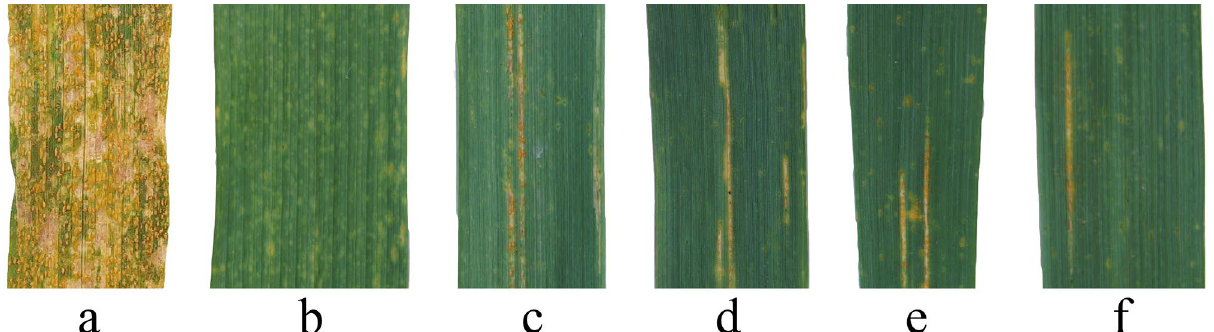
Figure 3. Stripe rust resistance of synthetic wheat at the adult stage. ( a ): SY95-71; ( b ): Ma; ( c ): Syn-SAU-116; ( d ): Syn-SAU-117; ( e ): Syn-SAU-118; ( f ):